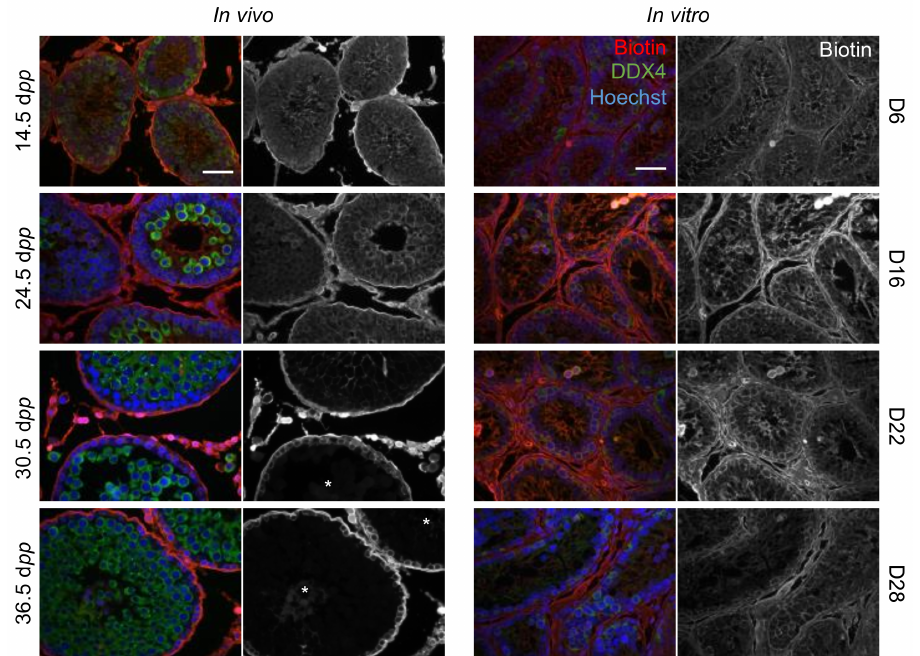
Figure 5. Analysis of the establishment and integrity of the blood–testis barrier throughout in vitro culture. The biotin tracer was revealed in red with Alexa fluor ® 594-conjugated streptavidin. A staining with a DDX4 antibody in green was performed to detect germ cells. Nuclei were coun- terstained with Hoechst. The in vivo kinetics showed a progressive establishment of the BTB. The absence of a functional BTB was highlighted by the presence of the biotin tracer within the adluminal compartment of seminiferous tubules at 14.5 and 24.5 dpp. Tubules with an in-tact BTB (annotated with a star) were observed at 30.5 dpp and 36.5 dpp: in these tubules, the biotin tracer was restricted to the basal compartment. In in vitro cultured tissues, biotin permeated throughout the seminiferous epithelium in all the tubules observed, showing an impairment in the establishment of the BTB.